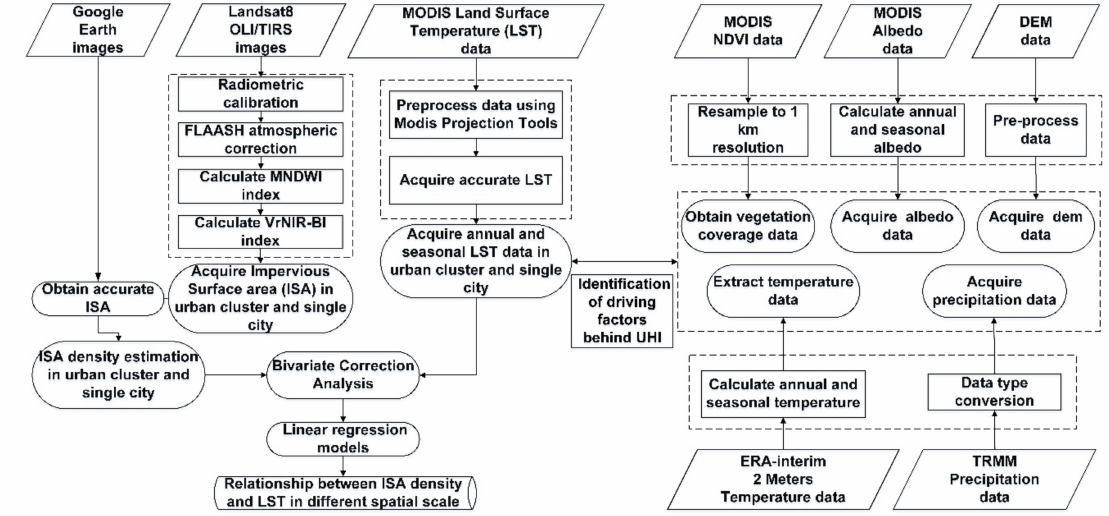
Figure 2. The working flow and analysis procedure of this current